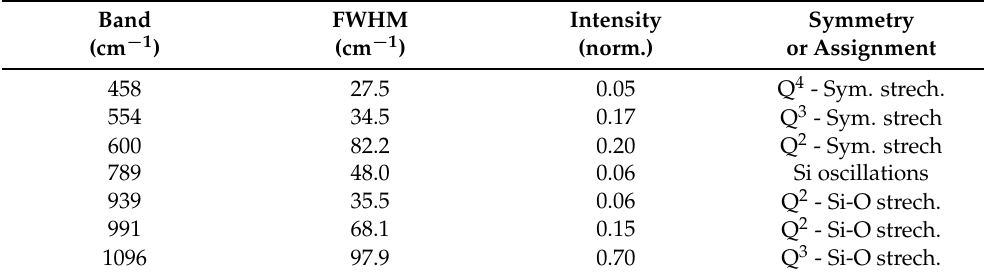
Table 2. Position, full width at half maximum and intensity of the soda–lime glass bands used to fit the spectra. Intensities are normalised to the most intense alumina peak at 417 cm − 1 . Sym. stretch.: symmetrical stretching. Si-O stretch: stretching of Si-O